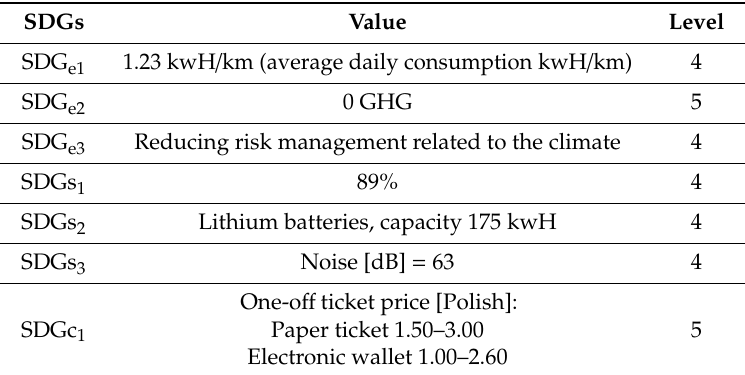
Table 2. Values of Sustainable Development Goals (SDGs) for the city of Zielona G ó ra.